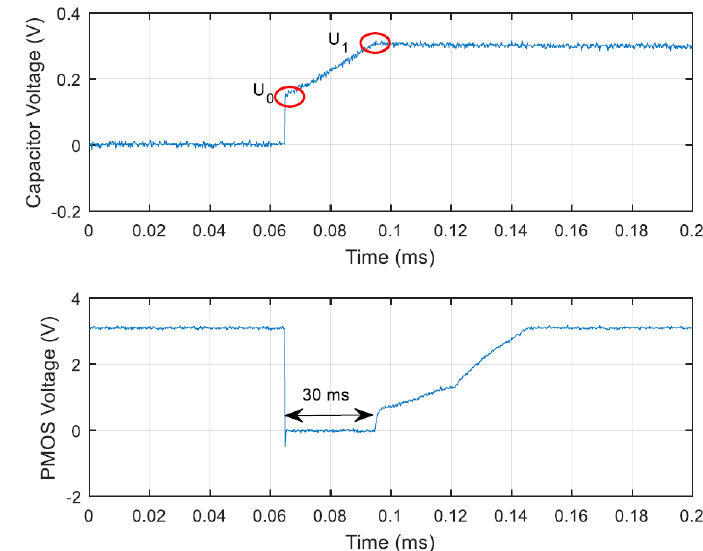
Figure 3. Example measurement of the capacitor voltage measurement and the voltage over switch A during a 30 ms measurement cycle. Illumination is happening with an incident power of 130 W/m 2 from a full spectrum daylight bulb.